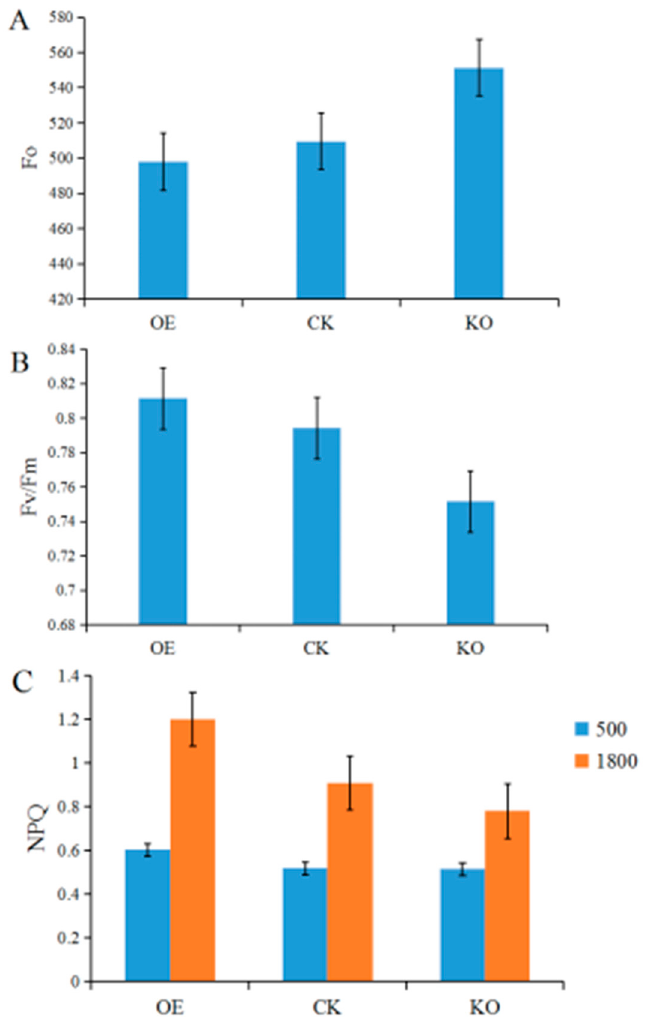
Figure 7. Chl fluorescence kinetic parameters of WT and the T 2 generation of GmRIQ2 - like- OE and KO transgenic soybean seedlings. ( A ), ( B ), and ( C ) represent the effects of different light intensities on the Fo, Fv/Fm, and NPQ of three types of soybean leaves. Vertical bars represent the SE ( n = 3; each treatment consisted of 30 seedlings).